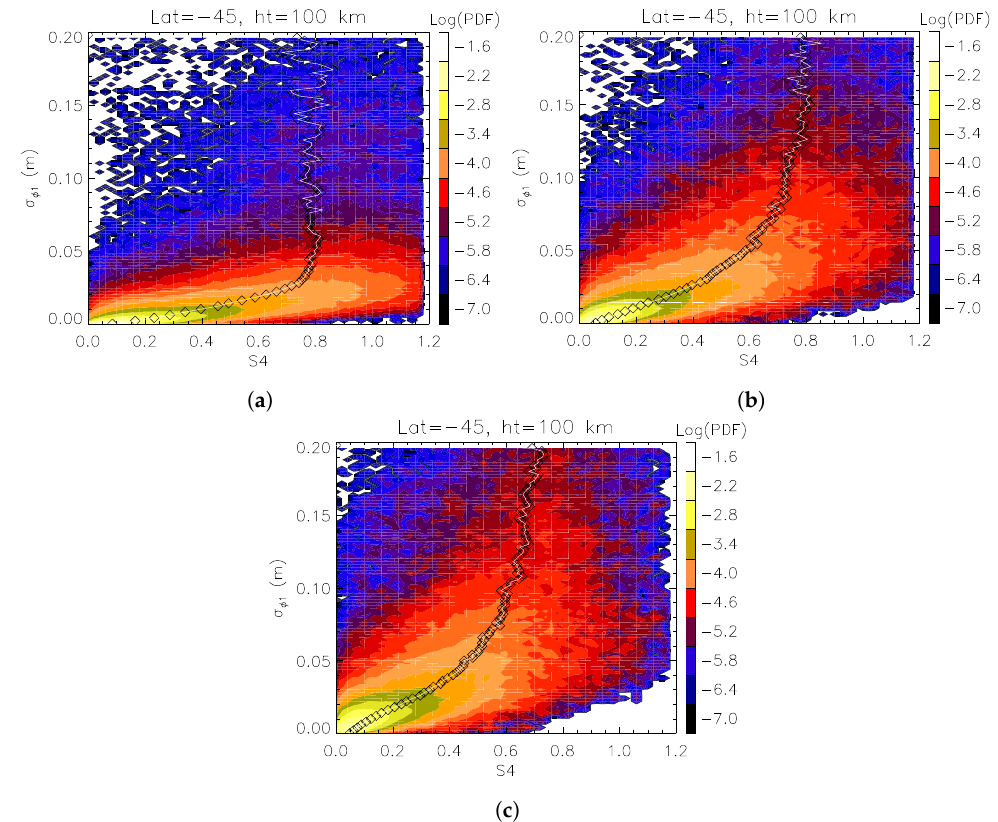
Figure 2. Joint S 4 - σ φ histograms: ( a ), ( b ), and ( c ) for truncation N cut = 51, 121 and 201, respectively, over all times during January 2008 between − 40 ◦ and − 50 ◦ latitude and 100 km altitude where E s is maximized. The symbol line in each panel highlights the S 4 peak value at each σ φ bin. The S 4 and σ φ bin sizes are 0.02 and 2 mm, respectively, and the white bins indicate no data. All 2D histograms are normalized by their peak values, and a total of ∼ 1.1 million samples were used to create the